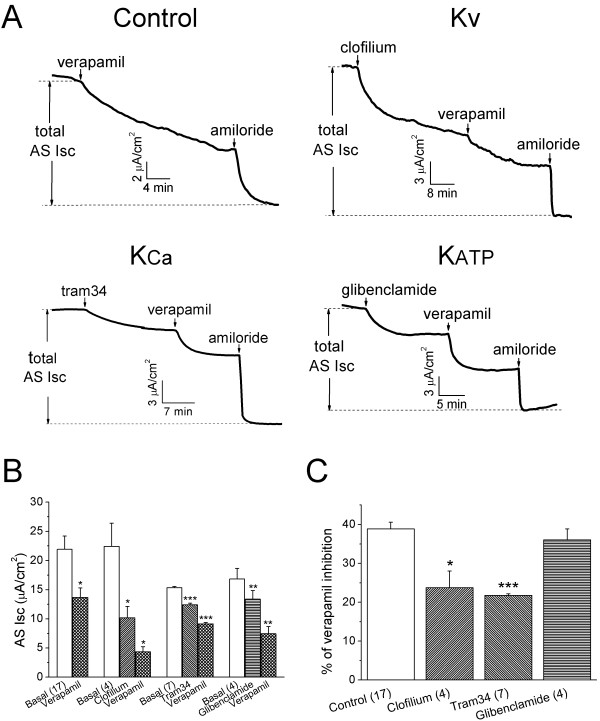
K+ channel blockers alter the inhibitory effects of verapamil in H441 cells. (A) Typical Isc traces showing the application of 100 μM verapamil alone (control), 100 μM clofilium (KV inhibitor), 20 μM tram34 (KCa3.1 inhibitor), and 100 μM glibenclamide (KATP inhibitor), respectively. These K+ channel blockers were applied to basolateral side followed by verapamil and amiloride (apical side) to compute total AS Isc. (B) Summary of average AS Isc levels. Paired t-test. *P < 0.05, **P < 0.01, *** P < 0.001 for comparison of pre- and post exposure of CCB. n = 4-17. (C) Reduced percentages of AS Isc levels by verapamil in H441 cells with and without pretreatment of K+ channel blockers. Two-sample, two-tailed t-test. *P < 0.05 vs Control. n = 4-17.